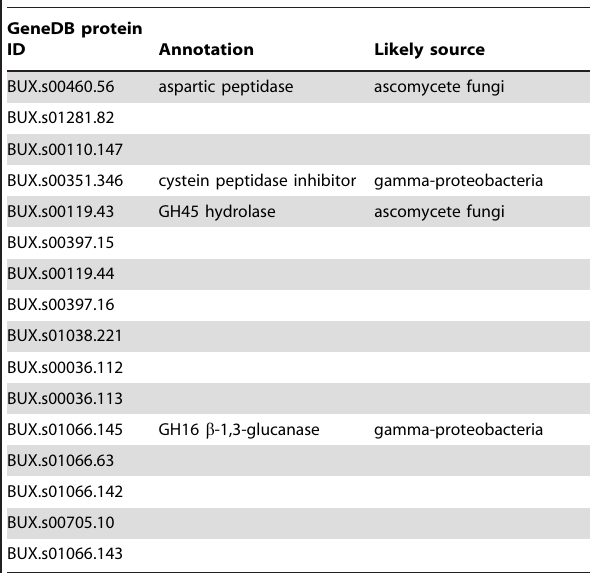
Table 3. Putatively horizontally transferred proteins, supported by phylogenetic evidence, secreted from Bursaphelenchus xylophilus